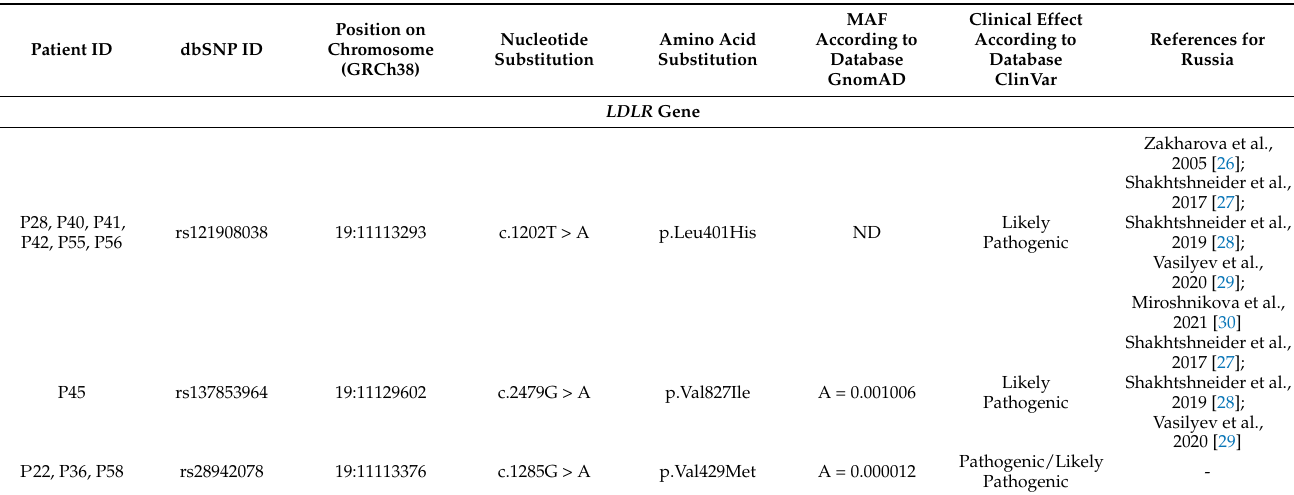
Table 2. The genetic variants identified in Western Siberia patients with a phenotype of Familial Hypercholesterolemia. MAF: minor allele